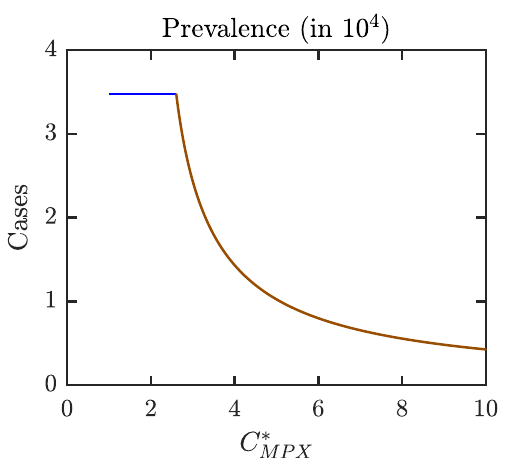
Fig 7. MPX prevalence in a population that uses optimal voluntary vaccination rates. The lines are color coded corresponding to the regions shown in Fig 9 which shows a diagram for Nash equilibria as e and C � the only NE and it is CSNE. Brown: positive ψ NE is the only NE and it is CSNE. Unless varied or otherwise specified, the parameters are as in Table 1.